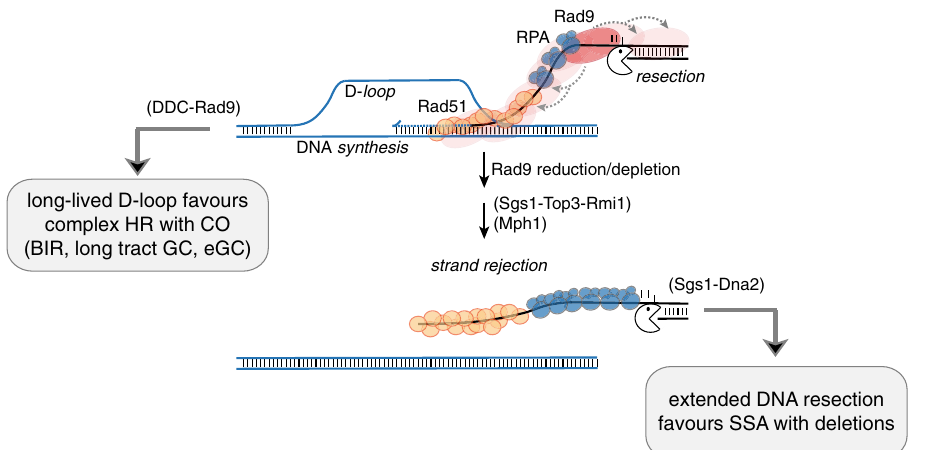
Fig. 7 Rad9 controls the nucleoprotein fi lament in recombination. After a DSB, the Rad9 oligomers assembled at the lesion limit: (i) the hyper-loading of recombination factors Rpa1, Rad52 and Rad52; (ii) the Sgs1-Top3-Rmi1 and Mph1 axes for the strand rejection, favouring long-lived D-loop and complex HR sub-pathways associated with CO (BIR, long-tract GC, eGC); (iii) the Sgs1-Dna2 axis for the long-range resection and single-strand-annealing (SSA) repair associated with